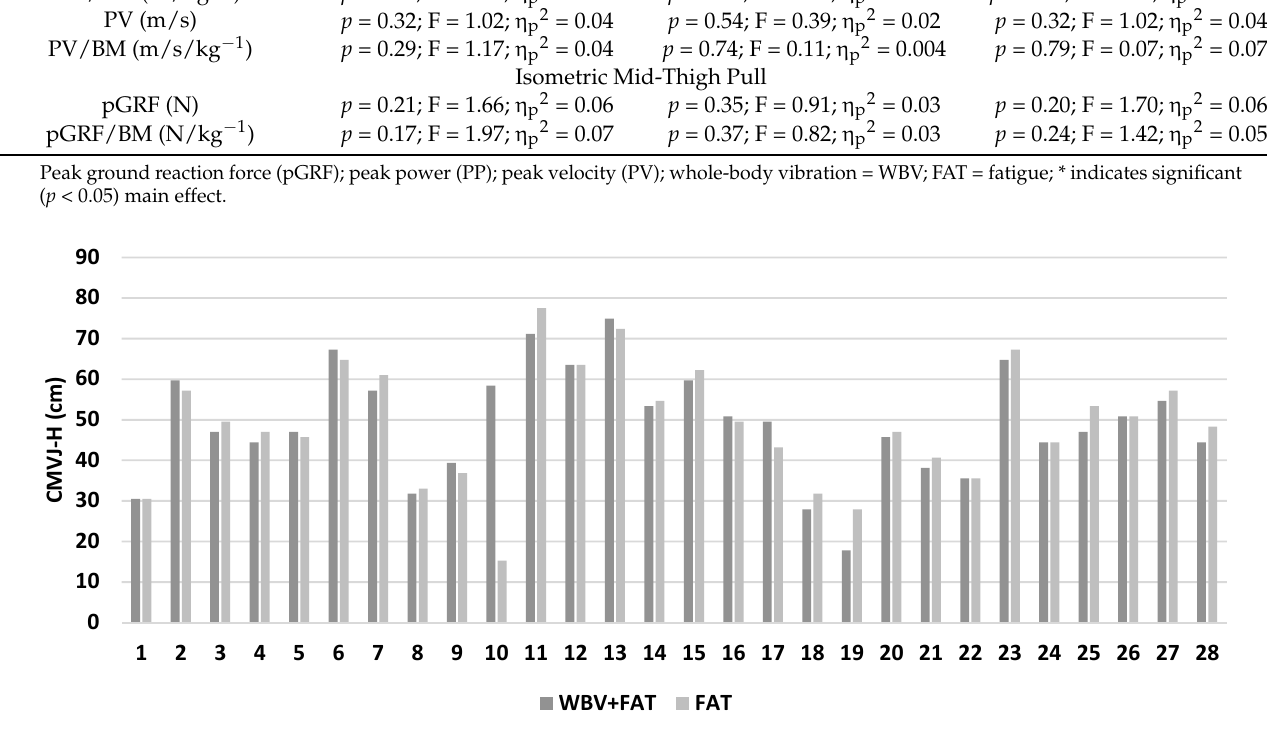
Figure 2. Individual countermovement vertical jump height (CMVJ-H) comparing conditions WBV + FAT and FAT.